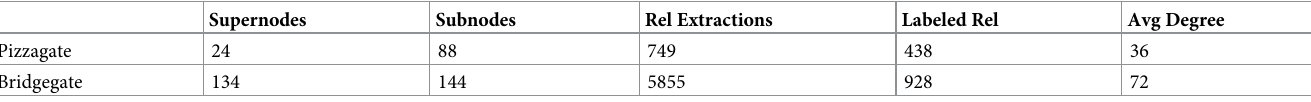
Table 1. Summary statistics for the extracted graphs from the two